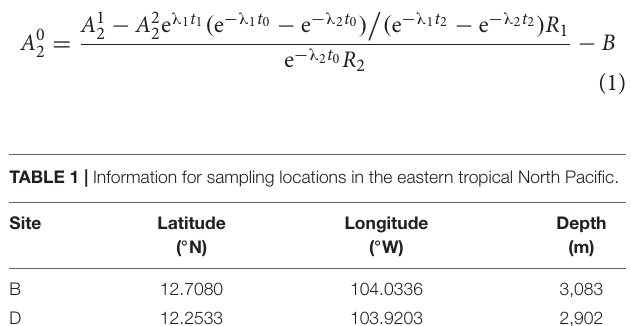
solution (HClO 4 , HNO 3 , and HF). The subsequent treatment is